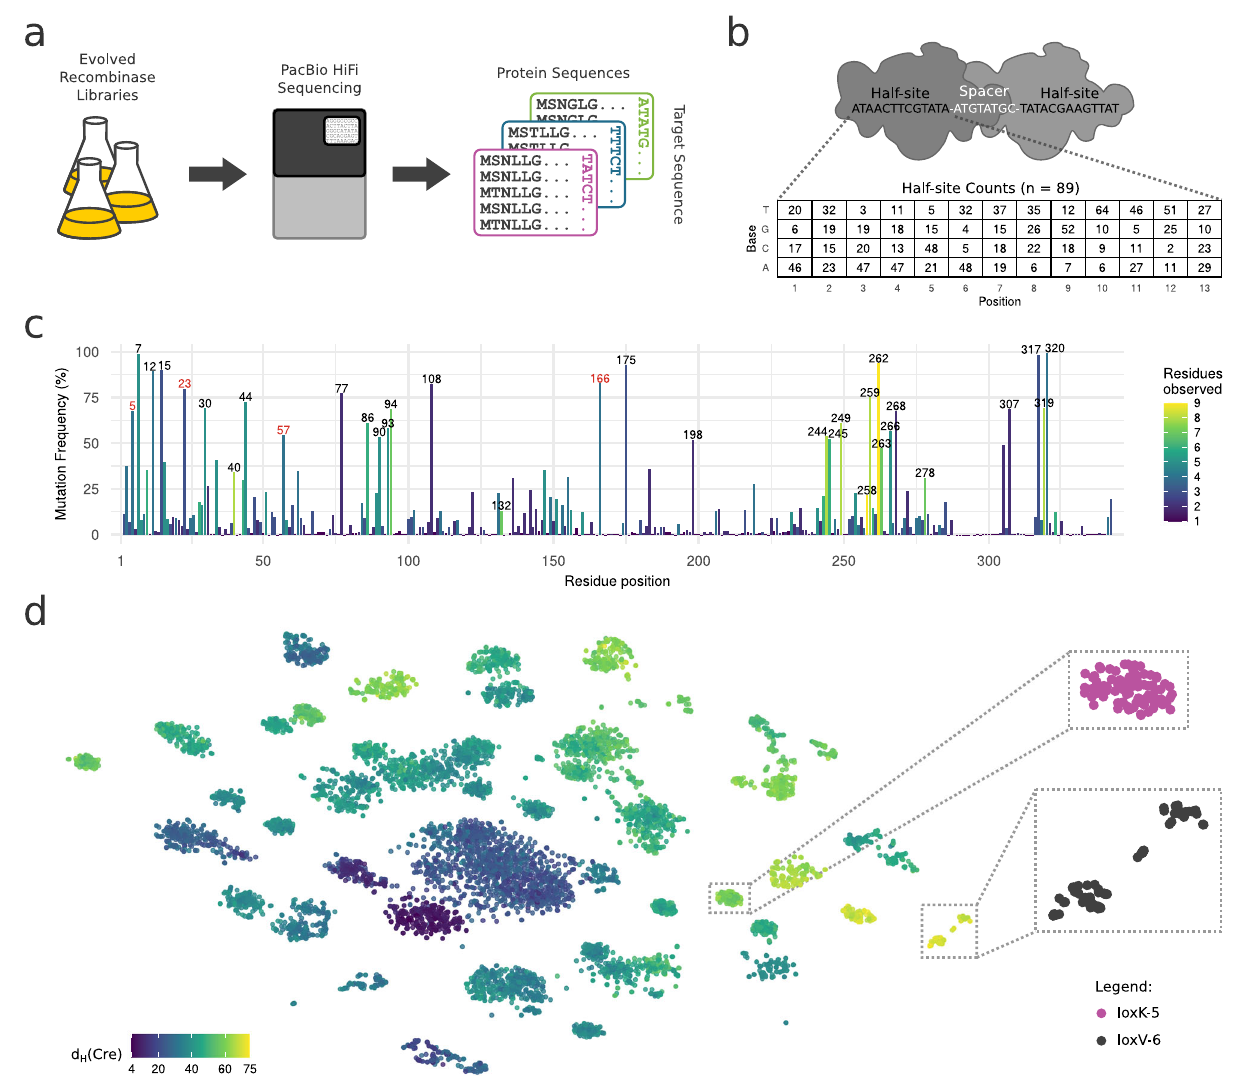
Fig. 1 | Data acquisition and overview of the recombinase sequence data for trainingthedeeplearningapproach.a Illustration describing the data collection. Evolved recombinase libraries were collected and sequenced with the PacBio HiFi method for high accuracy full length reads of the recombinase genes. Gene sequences were translated to protein and stored with the respective target sequences. b Illustration of Cre recombinase dimer binding the loxP DNA target sequence (top). All half-site bases covered by the sequenced recombinase libraries are shown on the bottom. The values in the coverage table indicate the number of target-sites with the respective base (rows) on the respective half-site position